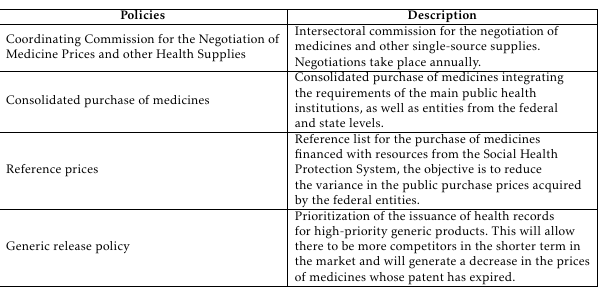
Figure 1. Mexico population pyramid, 2012-2030.